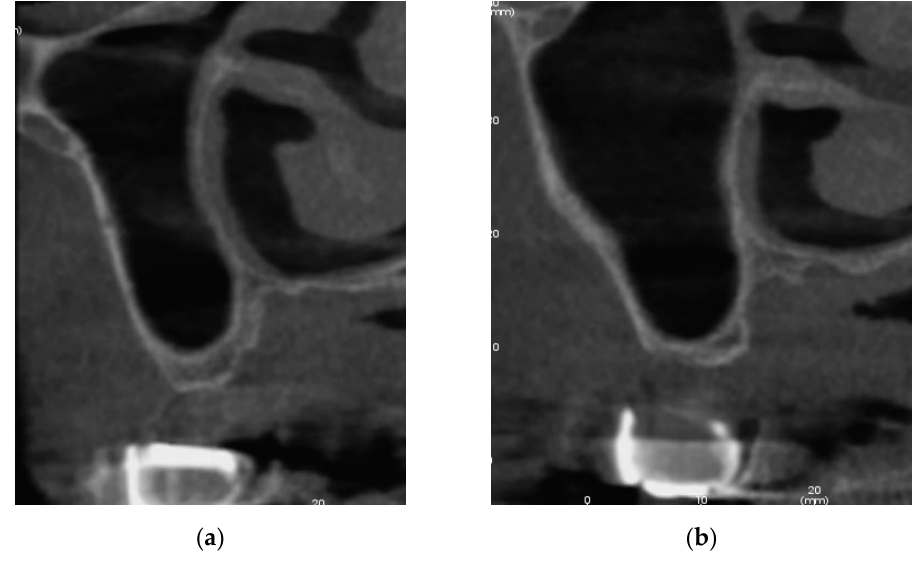
Figure 2. Patient #2. Preoperative CBCT cross-section images of the surgical sites showed: ( a ) second premolar area: adequate ridge width and 2.7 mm available bone height; ( b ) first molar area: ade- quate ridge width and 1.2 mm available bone height. Schneiderian membrane showed no signs of hypertrophy or inflammation.